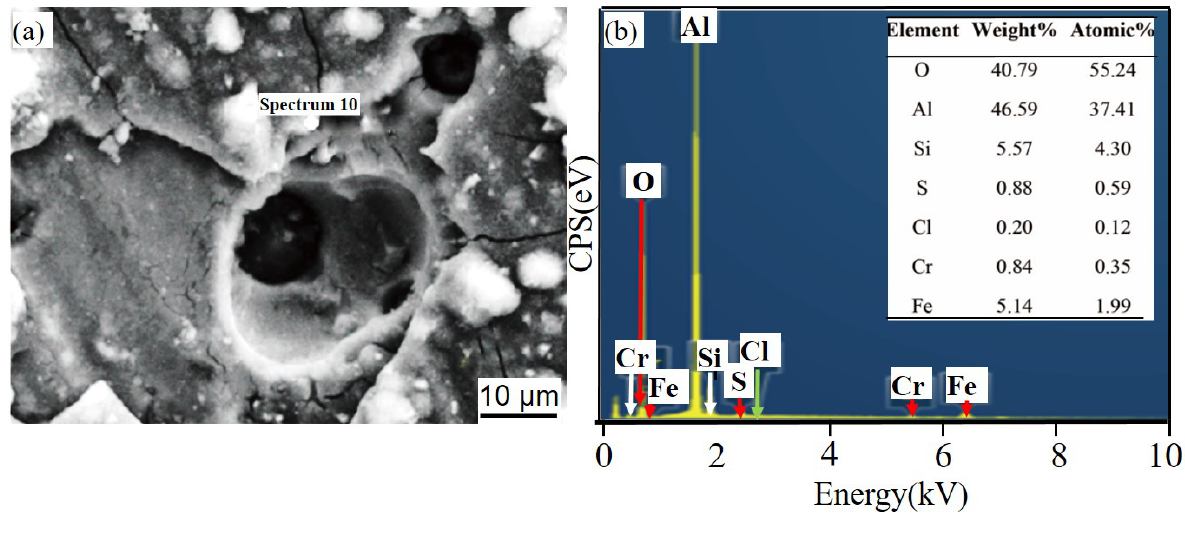
Figure 24. EDS of matrix cracks in 6061Al alloy after SL for 150 days. ( a ) SEM image of matrix cracks; ( b ) EDS of matrix cracks.